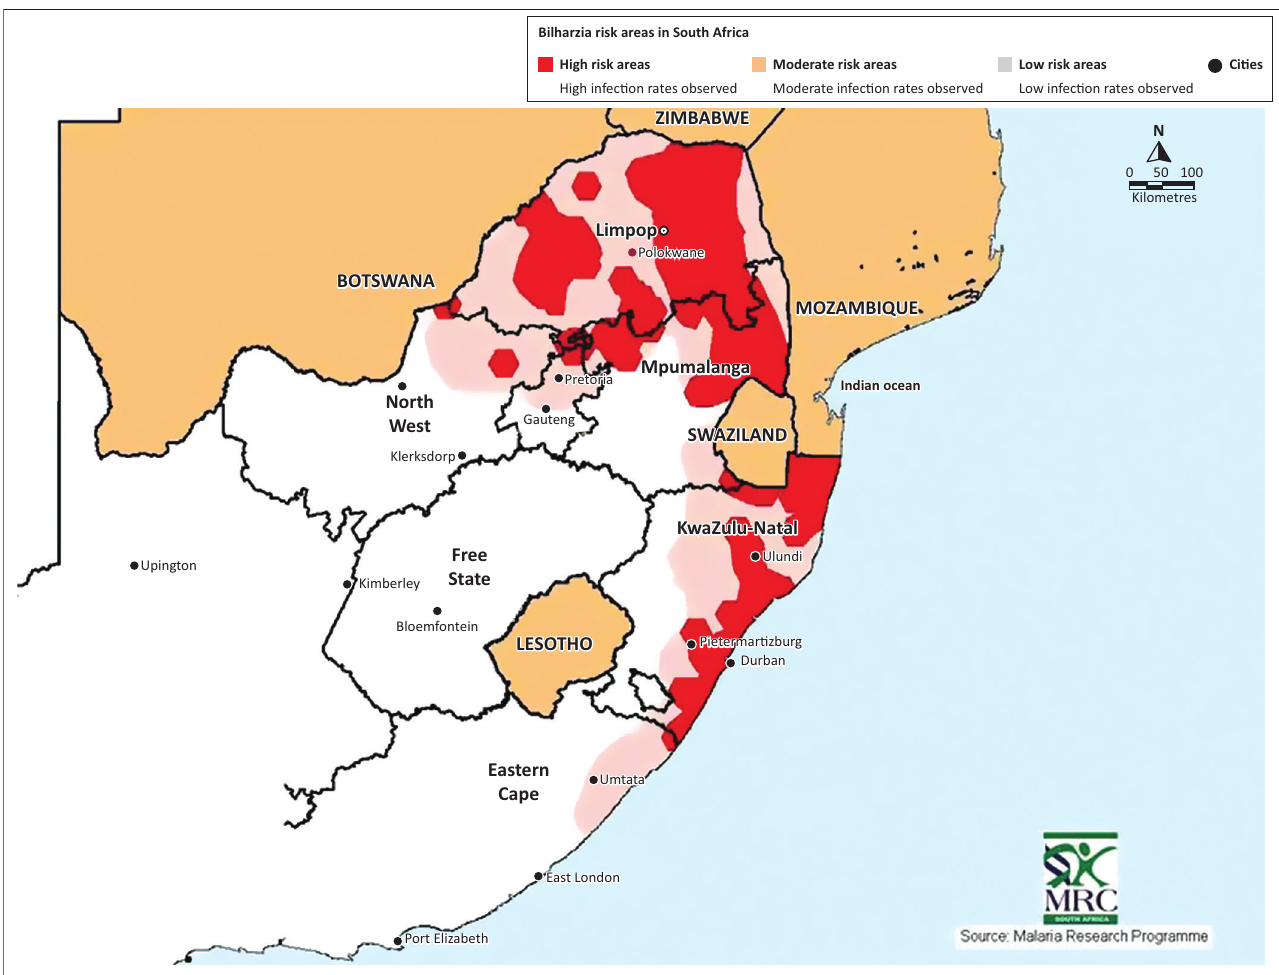
FIGURE 2: Schistosomiasis risk areas in South